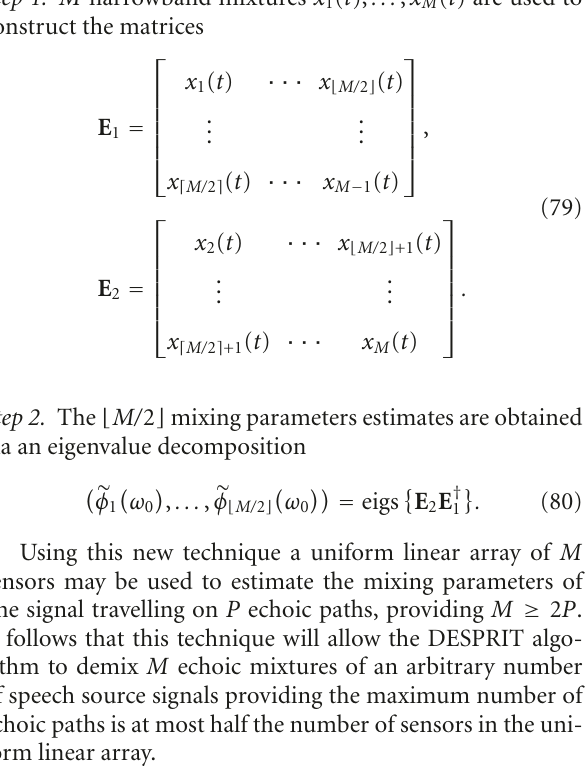
Our simplified ESPRIT algorithm (Section 2.1.1) may be adapted to this new